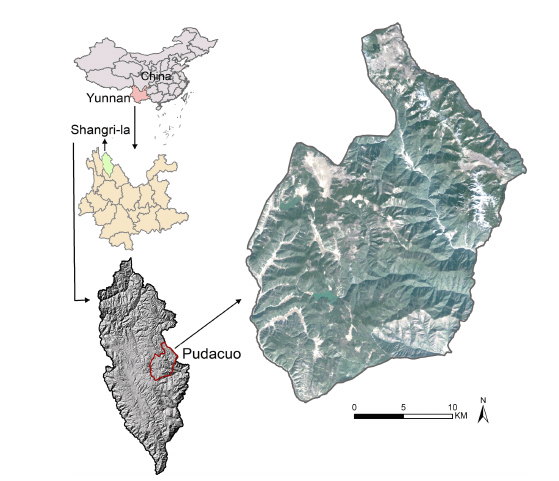
Fig. 1 . Location of study